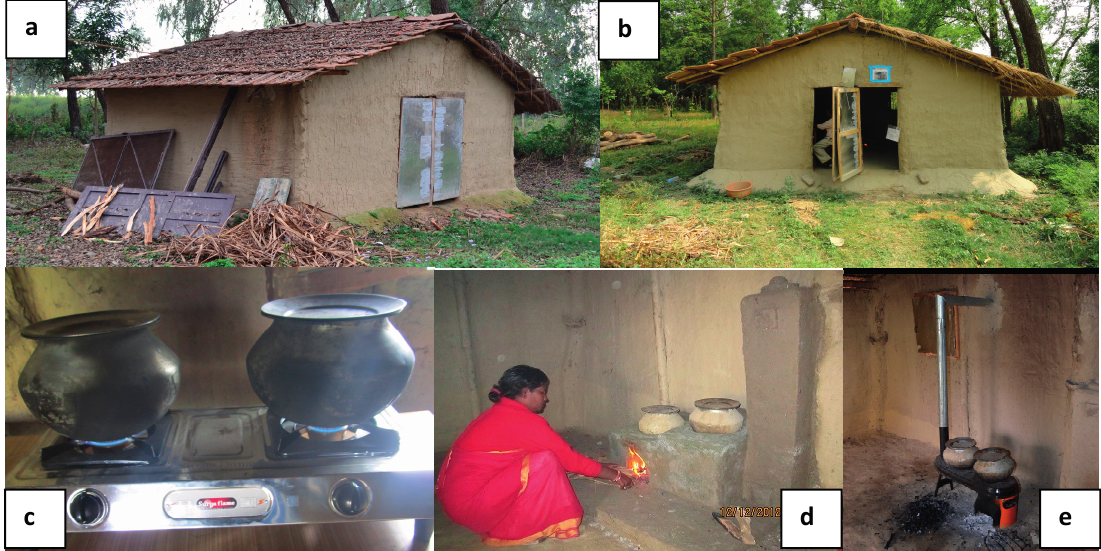
Figure 2. Study II photos of testing house and stoves used in water boiling test study in rural Nepal. ( a ) Single room test house (closed door), ( b ) single room test house (open door), ( c ) liquid propane gas stove (LPG), ( d ) alternative mud brick stove-II (AMBS-II), and ( e ) Envirofit G-series stove (representing MAES and NAES).